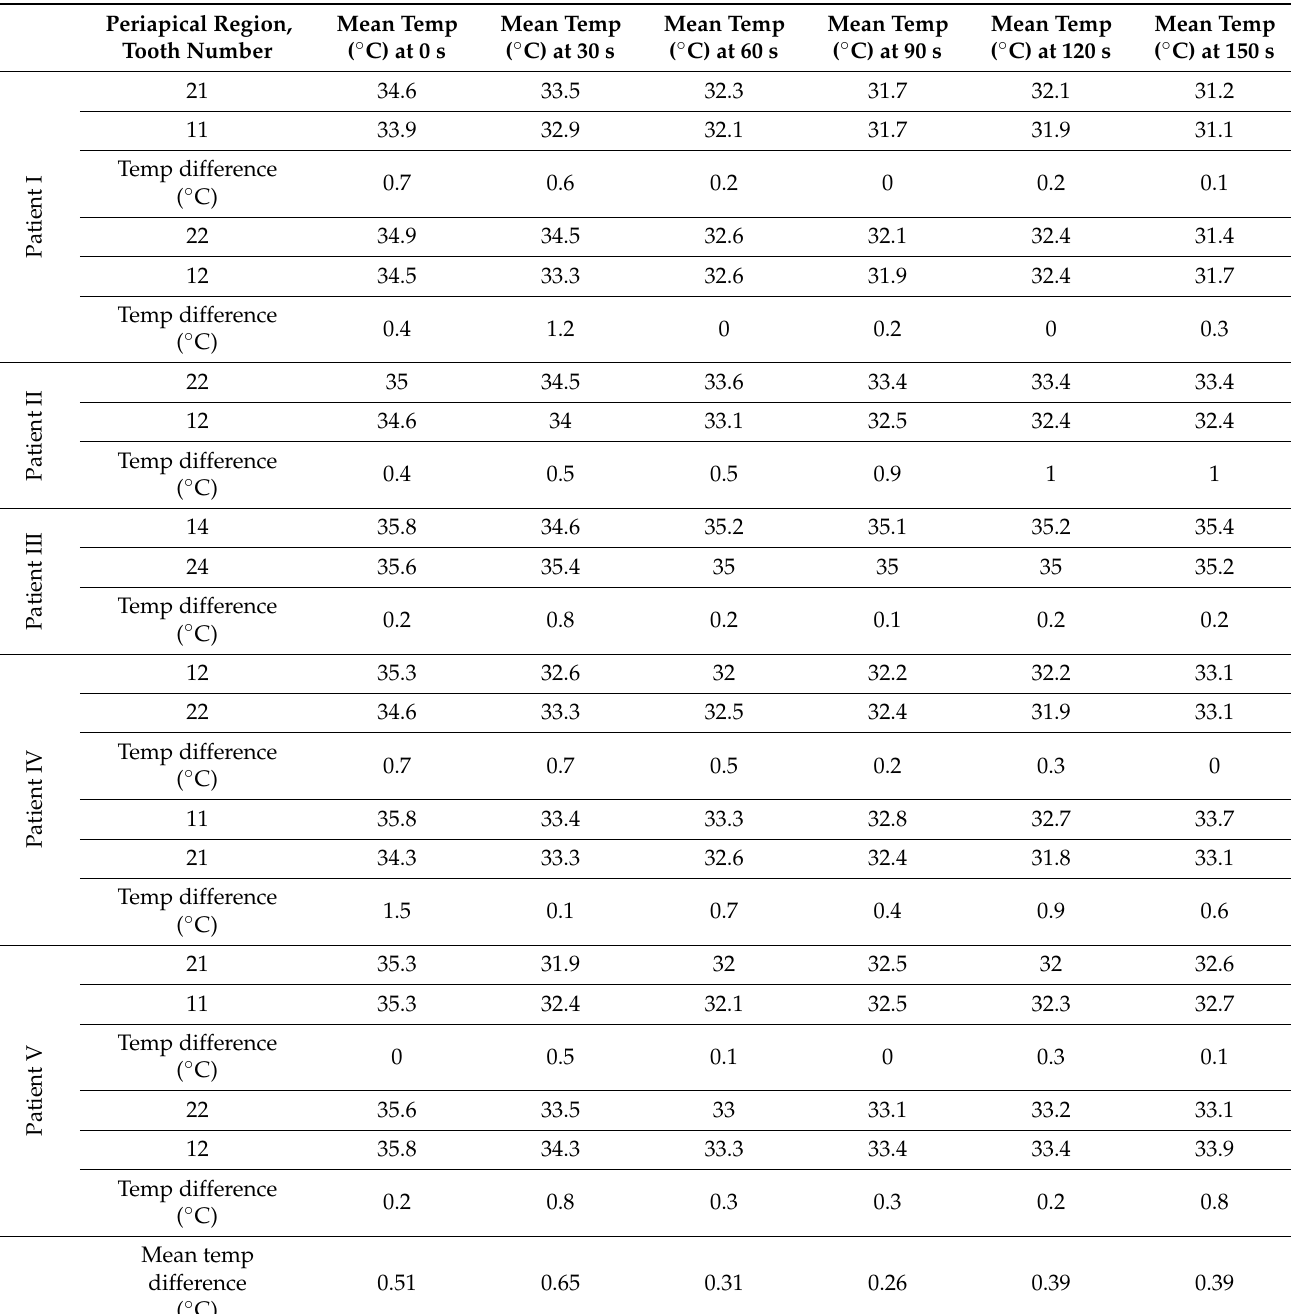
Table 1. Periapical regions of the suspect and contralateral healthy teeth—thermograms captured at 30 s intervals in five patients of the study